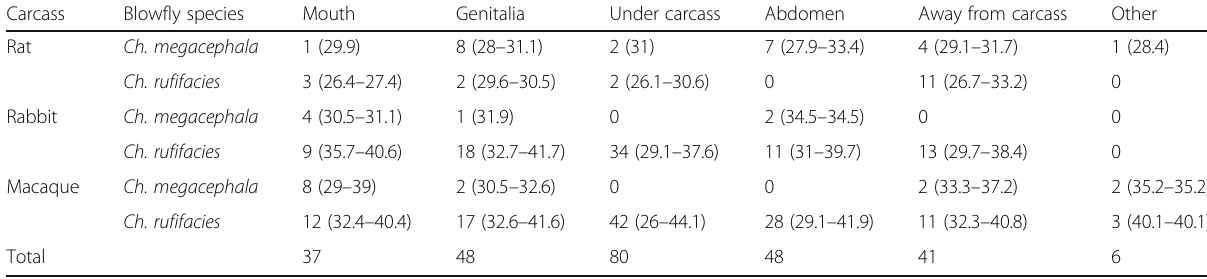
Table 2 Number of aggregation at five different locations in carcasses